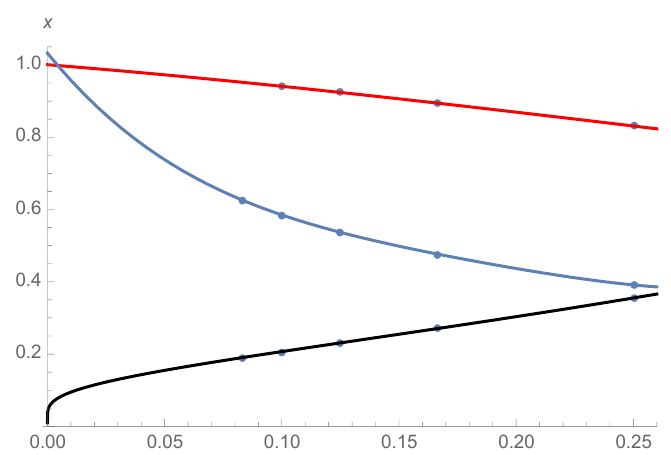
Figure 23 . The convergence of the first gap in the loop model in the sector with 2 j = 2 through lines, with γ = π . The black line corresponds to α = 0 in (6.1), the red line corresponds to 4 α = − 1 ’ − 1 . 41 , and the blue line corresponds to α = − 0 . 46 . We expect the first gap for cos γ to converge to 1 and the first gap for α = 0 to converge logarithmically to 0 , in α = − 1 cos γ agreement with the numerical results. Finally, we observe that when we perturb α slightly away from 0 the model flows under RG to α = − 1 . cos γ